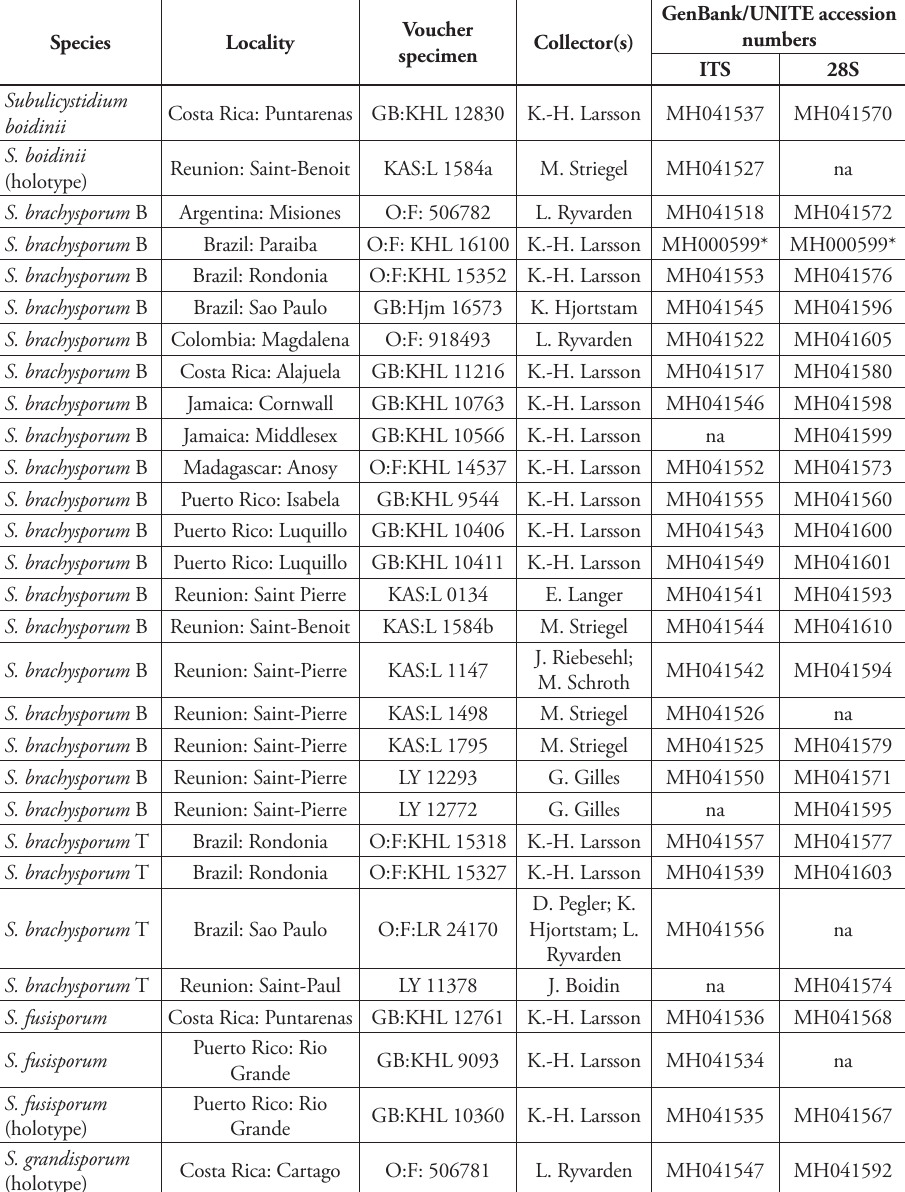
Table 1. Ribosomal DNA sequences used in this study with information on voucher specimens. Most sequences are newly generated for this study and ITS and 28S region were sequenced separately. For specimens GB:KHL 14229 and 16100 and TU 124388, single accession number in each case refers to a sequence containing both ITS and 28S regions. Sequences retrieved from other studies are marked with an asterisk. Abbreviation “na” means sequence is not available. In the species S. brachysporum, “B” means morphological species concept following Boidin and Gilles (1988), while “T” means the species as de- scribed by Talbot